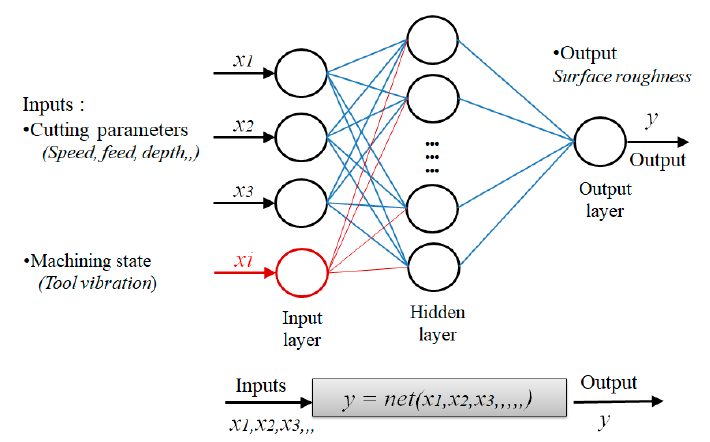
Figure 6. Multilayered architecture of a typical artificial neural network.